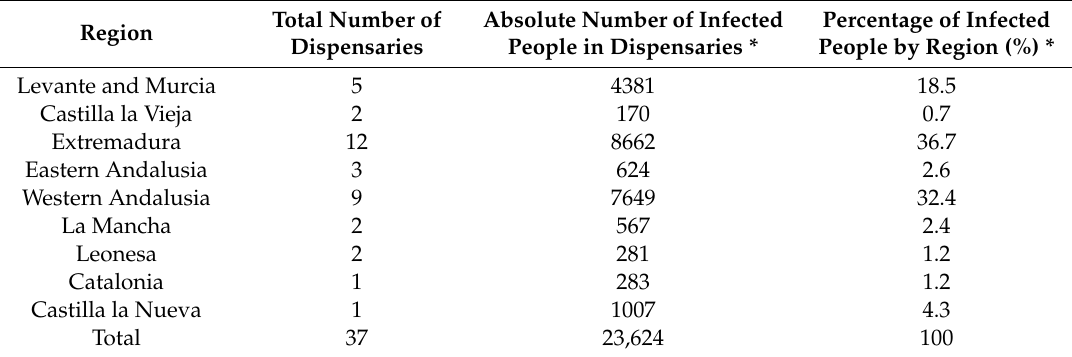
Table 2. Distribution of antimalarial dispensaries in Spanish regions in 1932. Total Number of Absolute Number of Infected Region Dispensaries People in Dispensaries *